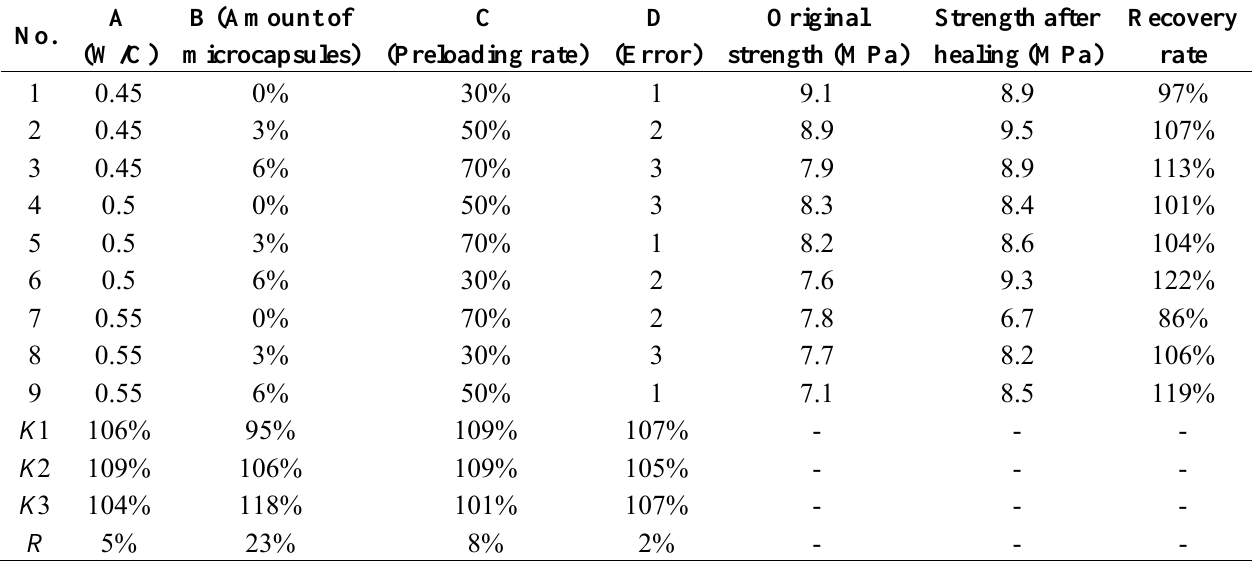
Table 2. Orthogonal experiments for flexural strength test: factors, levels, and